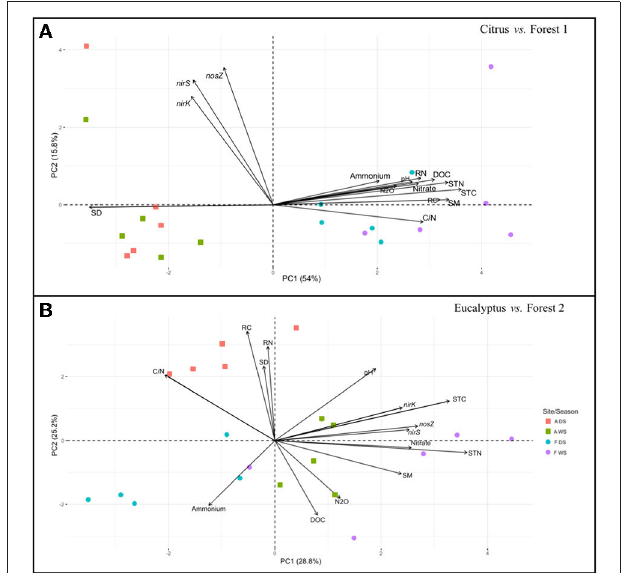
FIGURE 4 | Principal component analysis plot based on the nirK, nirS, and nosZ gens abundances, N 2 O fluxes, and soil physicochemical and plant residue chemical factors as determined in the soil incubation experiment samples. (A) Citrus and Forest 1 sites and (B) Eucalyptus and Forest 2 sites. The symbols are identical to those defined in Figure 3